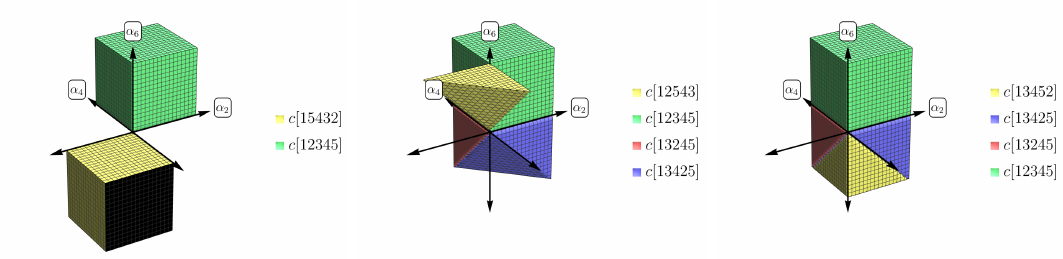
Figure 10 . Geometric realizations of three different types of KK relations for n = 5 : (left) the reflection relation in (5.8a); (middle) the KK relation in (5.8b); (right) the U(1) decoupling identity in (5.8c). Each region is a cone emanating from the